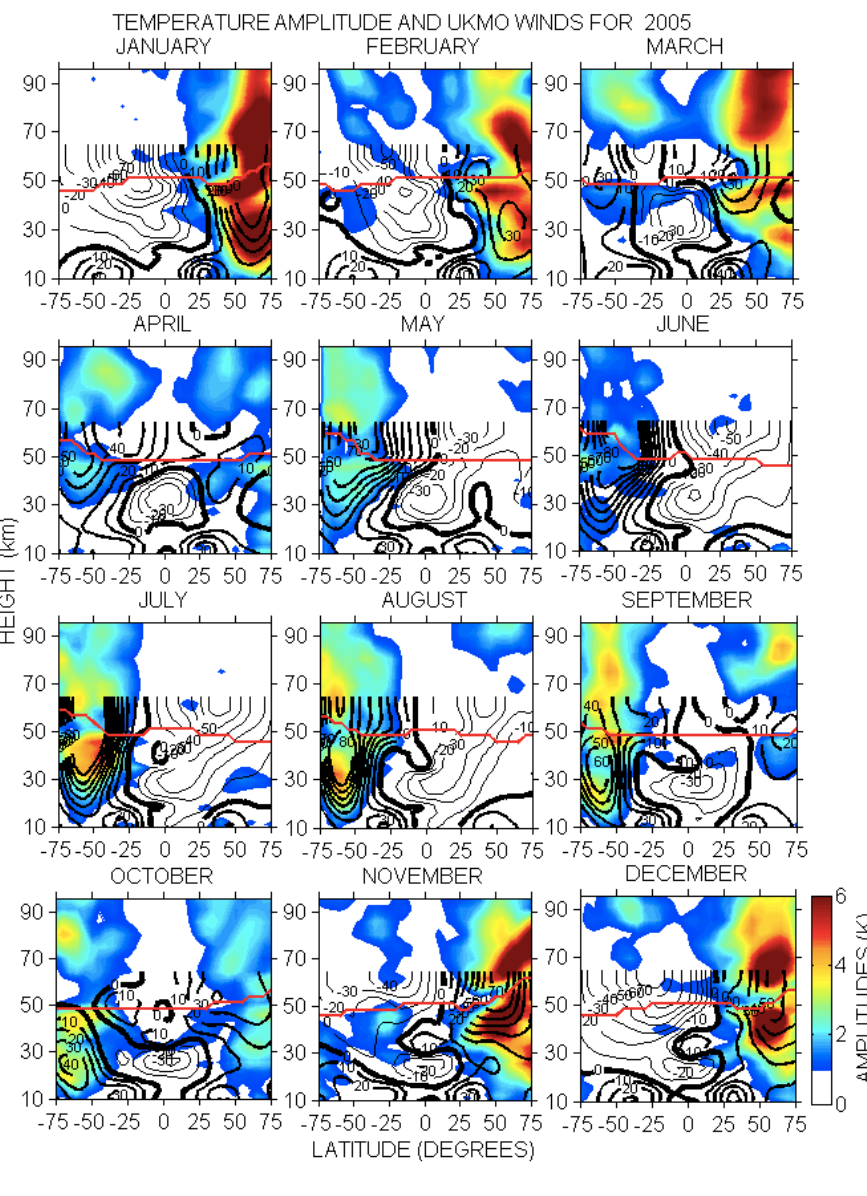
Fig. 6. Monthly-mean temperature amplitudes of the 16-day wave for 2005. Also plotted are the 2005 UKMO monthly-mean zonal winds (ms − 1 ) as contour lines and the stratopause height as a red contour